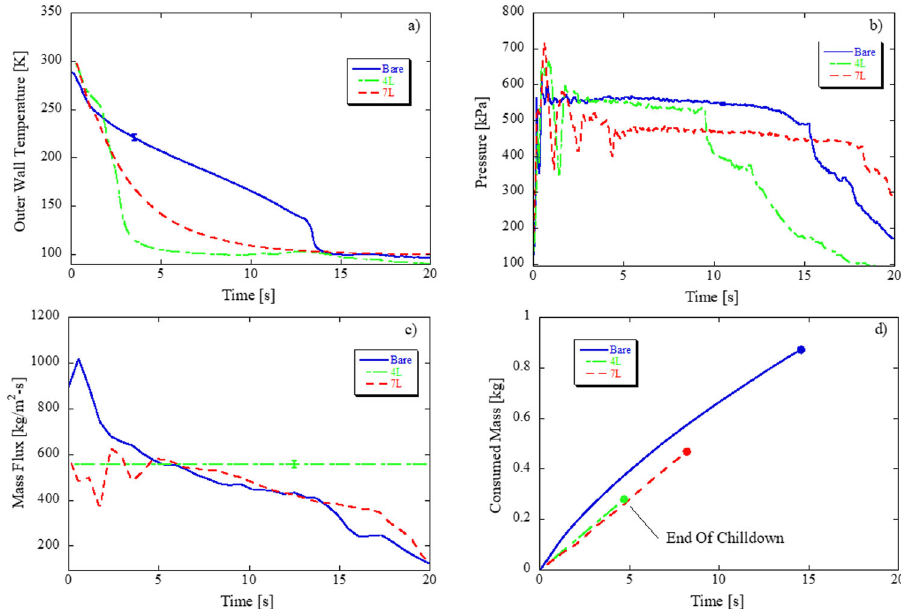
Fig. 2 Effect of te fl on coating thickness in microgravity: 550 kPa source pressure, continuous fl ow, 0.05 G level (g/g0). F2 (Flight_Day1_2, 67324 Re, bare surface) versus F22 (Flight_Day4_1, 74196 Re, 4 L coating) versus F13 (Flight_Day3_1, 63912 Re, 7 L coating) a Chilldown curve, b exit pressure, c mass fl ux, and d total propellant mass consumed based on averaged exit wall